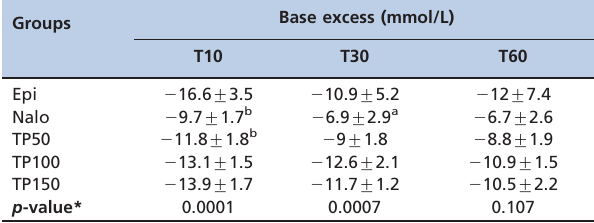
Table 3 - Mean arterial pressure: comparisons of the groups vs. time Groups